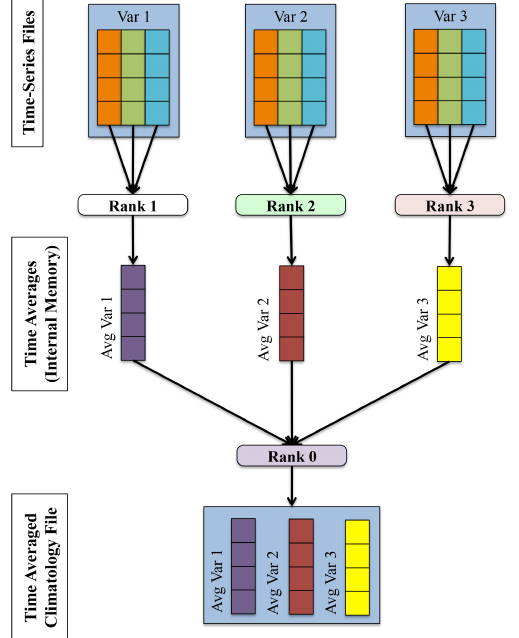
Figure 4. A depiction of the parallelism strategy that the PyAv- erager uses for writing each climatology file. This figure de- scribes how four MPI ranks are tasked within an example sub- communicator.